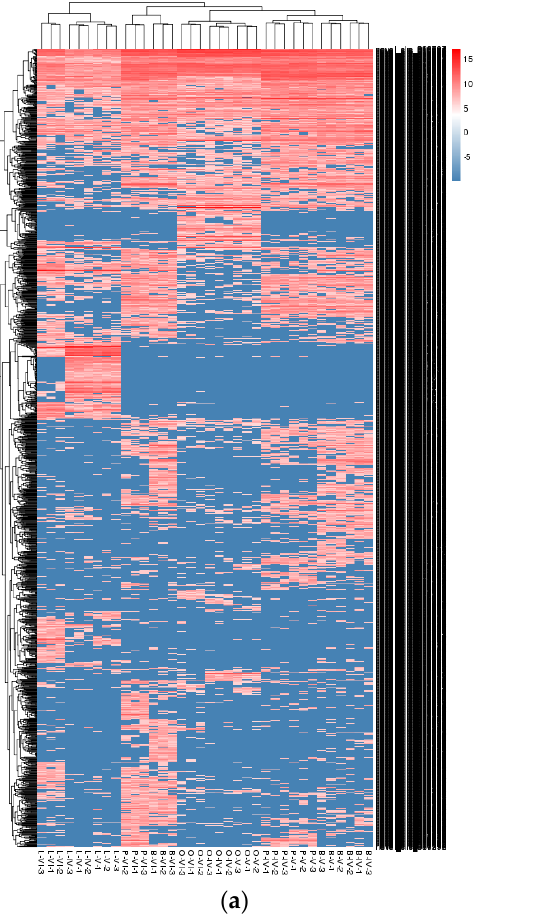
Figure 2. The total differentially expressed circRNAs. ( a ) Clustered heat map of differentially expressed circRNAs in the ovary (O), brain (B), pituitary (P) and liver (L) when comparing the IV-V, V-VI and IV-VI ovarian stages. ( b ) The statistical histogram of the number of differentially expressed circRNAs between different tissues and ovarian stages.